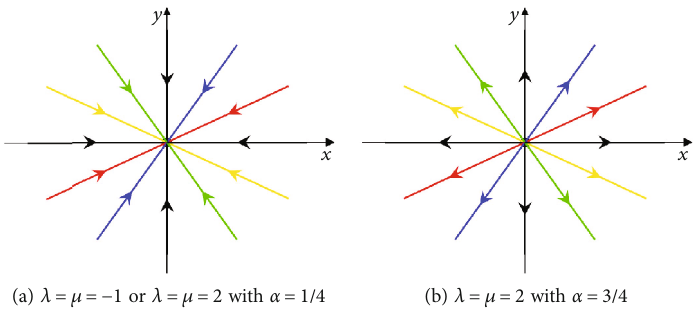
Figure 2: The phase portraits of system (8) for λ = μ at di ff erent α